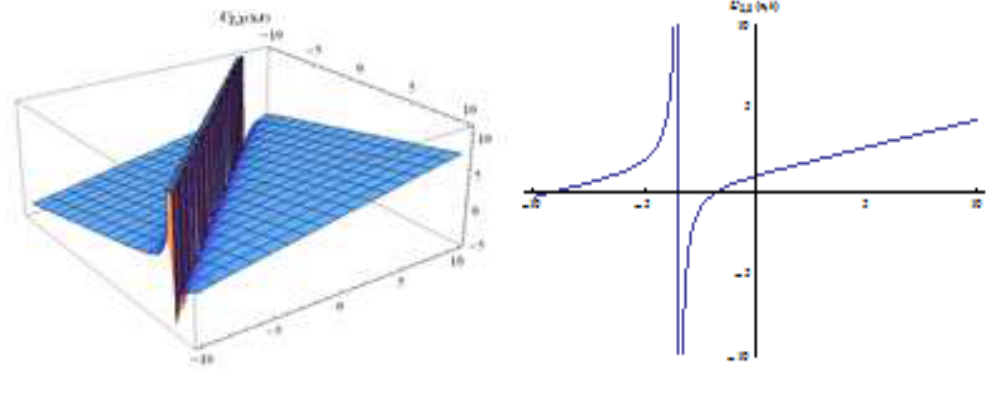
Figure 6: The 3D and t = 1for 2D of Eq.(23)